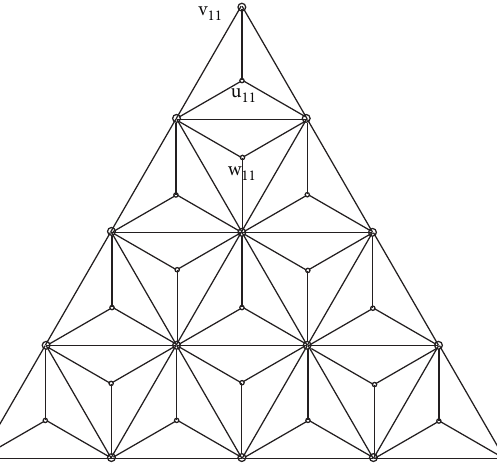
Figure 2: The graph of equilateral triangular tetra